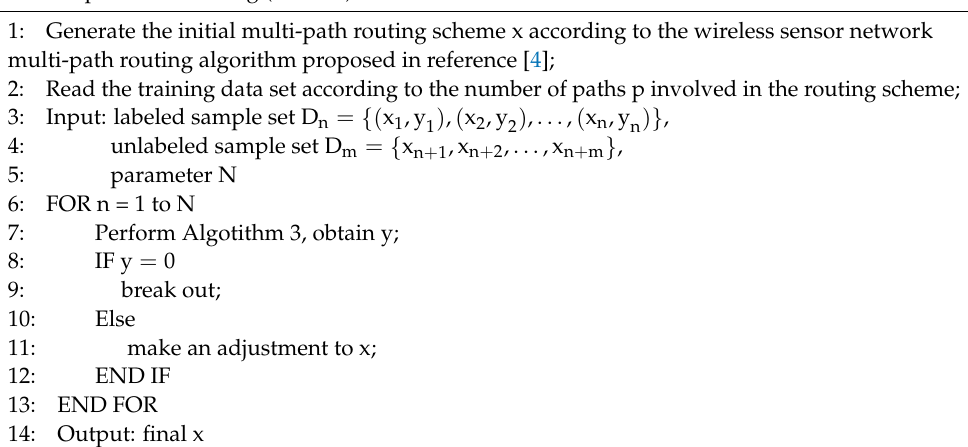
Algorithm 4: Multi-path routing algorithm for wireless sensor networks based on semi-supervised learning